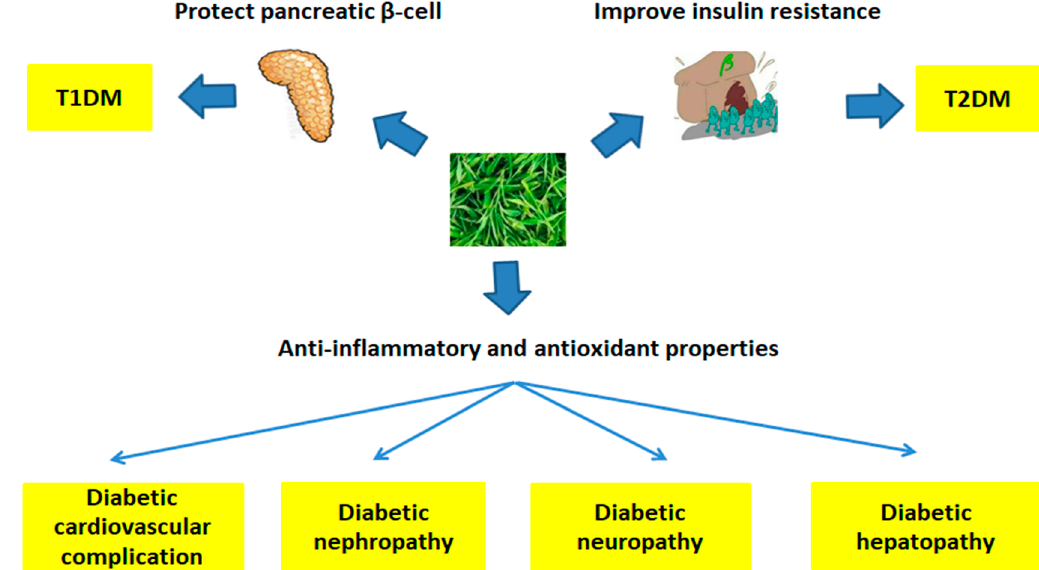
Figure 3. The association between tea and diabetes and its complications. Tea has effects on type 1 diabetes mellitus (T1DM) and type 2 diabetes mellitus (T2DM) by protecting pancreatic β -cells and ameliorating insulin resistance. Besides, due to the anti-inflammatory and antioxidant properties of tea, diabetic complications, including diabetic cardiovascular complication, diabetic nephropathy, diabetic neuropathy, and diabetic hepatic tissue injury, could be prevented and treated by tea and its bioactive components.